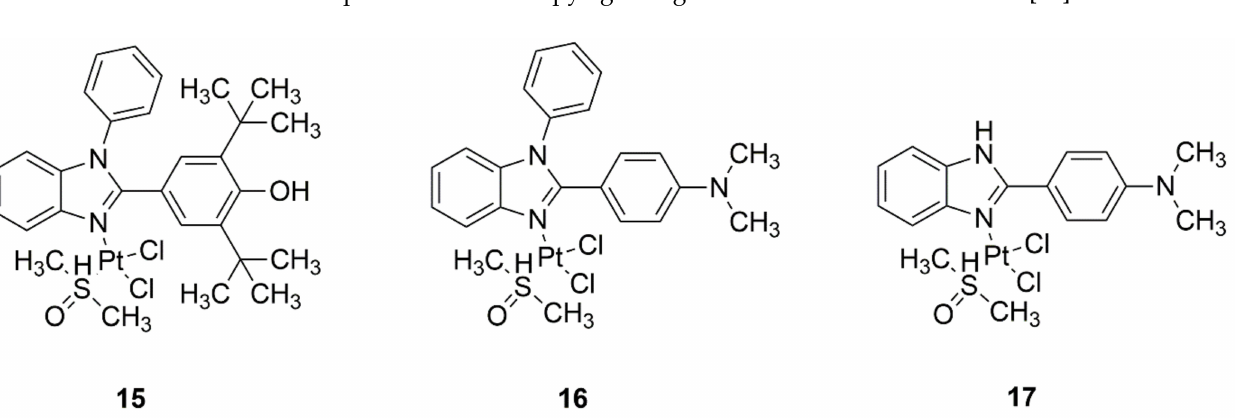
Figure 6. Structures of platinum(II) complexes with ( 15 ) 2,6-di-tert-butyl-4-(1-phenyl-1 H -benzimidazol-2-2yl) phenol, ( 16 ) N,N-dimethyl-4-(1-phenyl-1 H -benzimidazol-2-yl) aniline, and ( 17 ) 4-(1 H -benzimidazol-2-yl)-N,N-dimethylaniline.